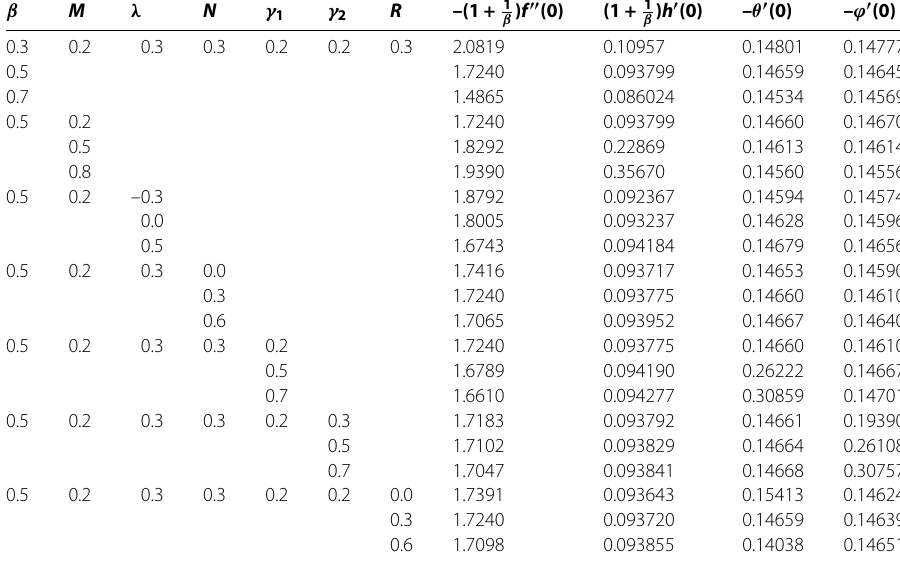
Table 2 Mathematical values of physical constraints at the boundaries for altered values of factors β , R , M , γ 1 , γ 2 when m = 0.5, Pr = 1.0, Sc = 0.7 and (cid:2) f = (cid:2) h = (cid:2) θ = (cid:2) ϕ =